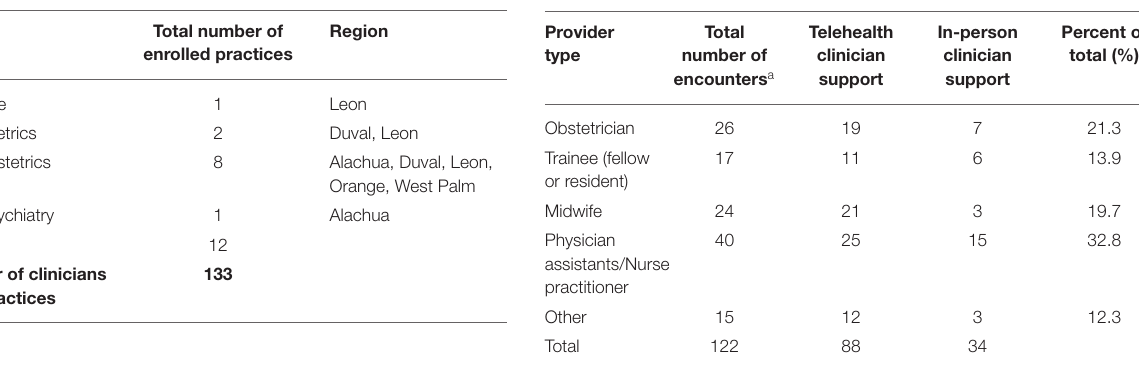
TABLE 1 | Clinical practice enrollment by type, location, and number of providers enrolled between October 1, 2019 to June 30, 2021.